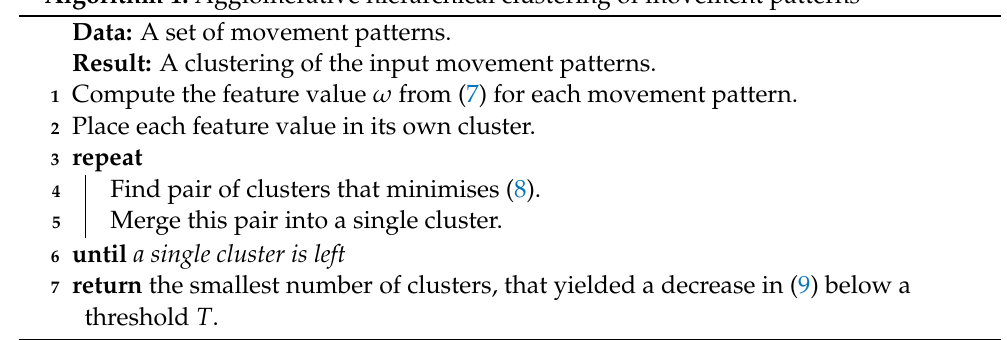
Algorithm 1: Agglomerative hierarchical clustering of movement